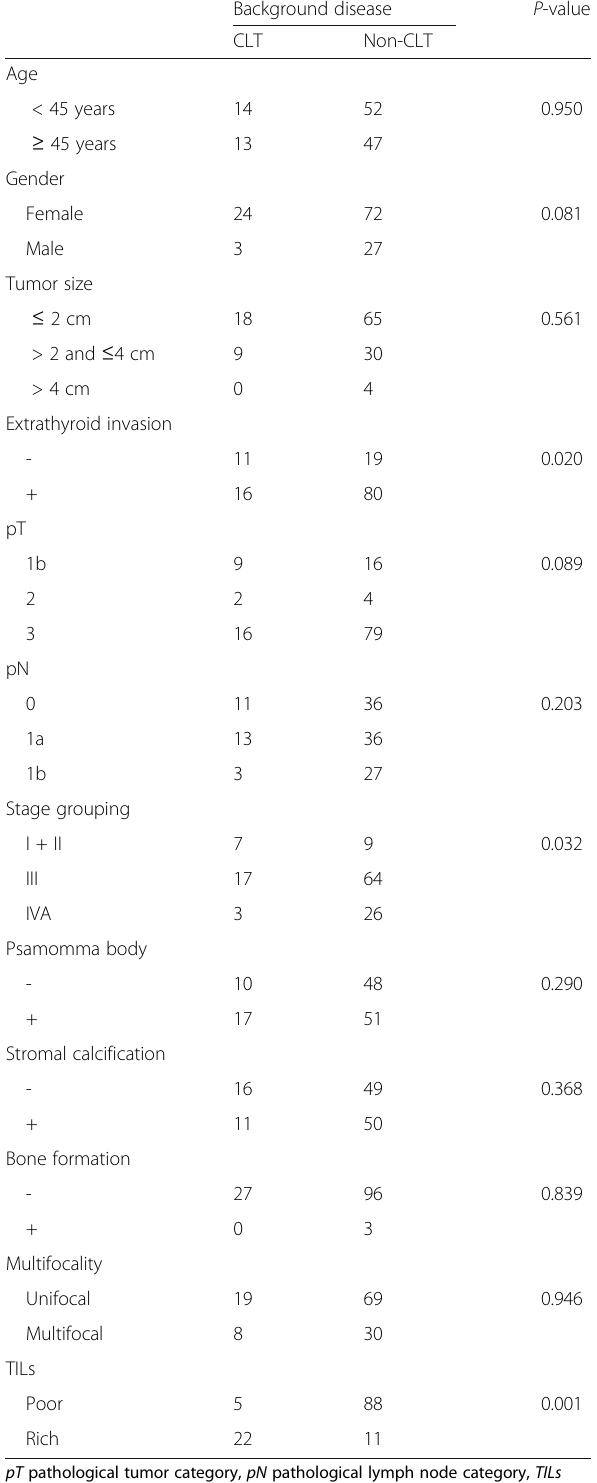
Table 3 The correlation between the background disease and other clinicopathological parameters Background